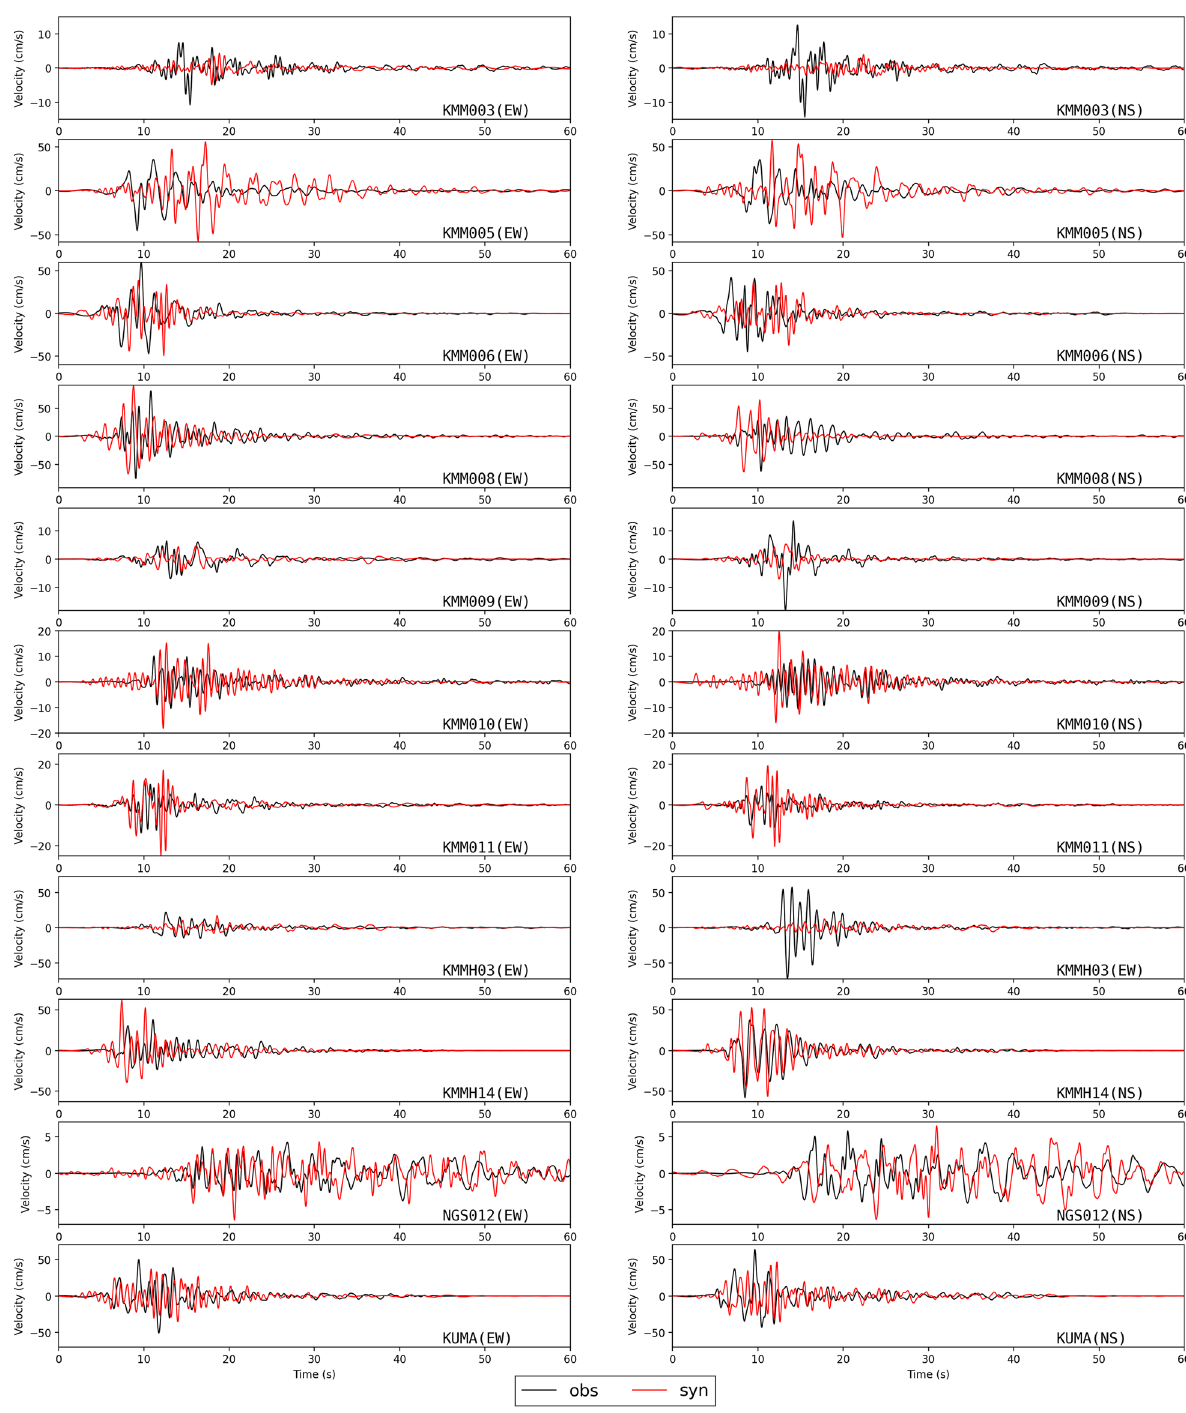
Fig. 13 Synthetic and observed velocity time histories (0.2–2 Hz) of the reference case for the earthquake of 2016/04/16 01:25 ( M w 7.1). Black lines indicate the observed velocities. Red lines indicate the synthetic